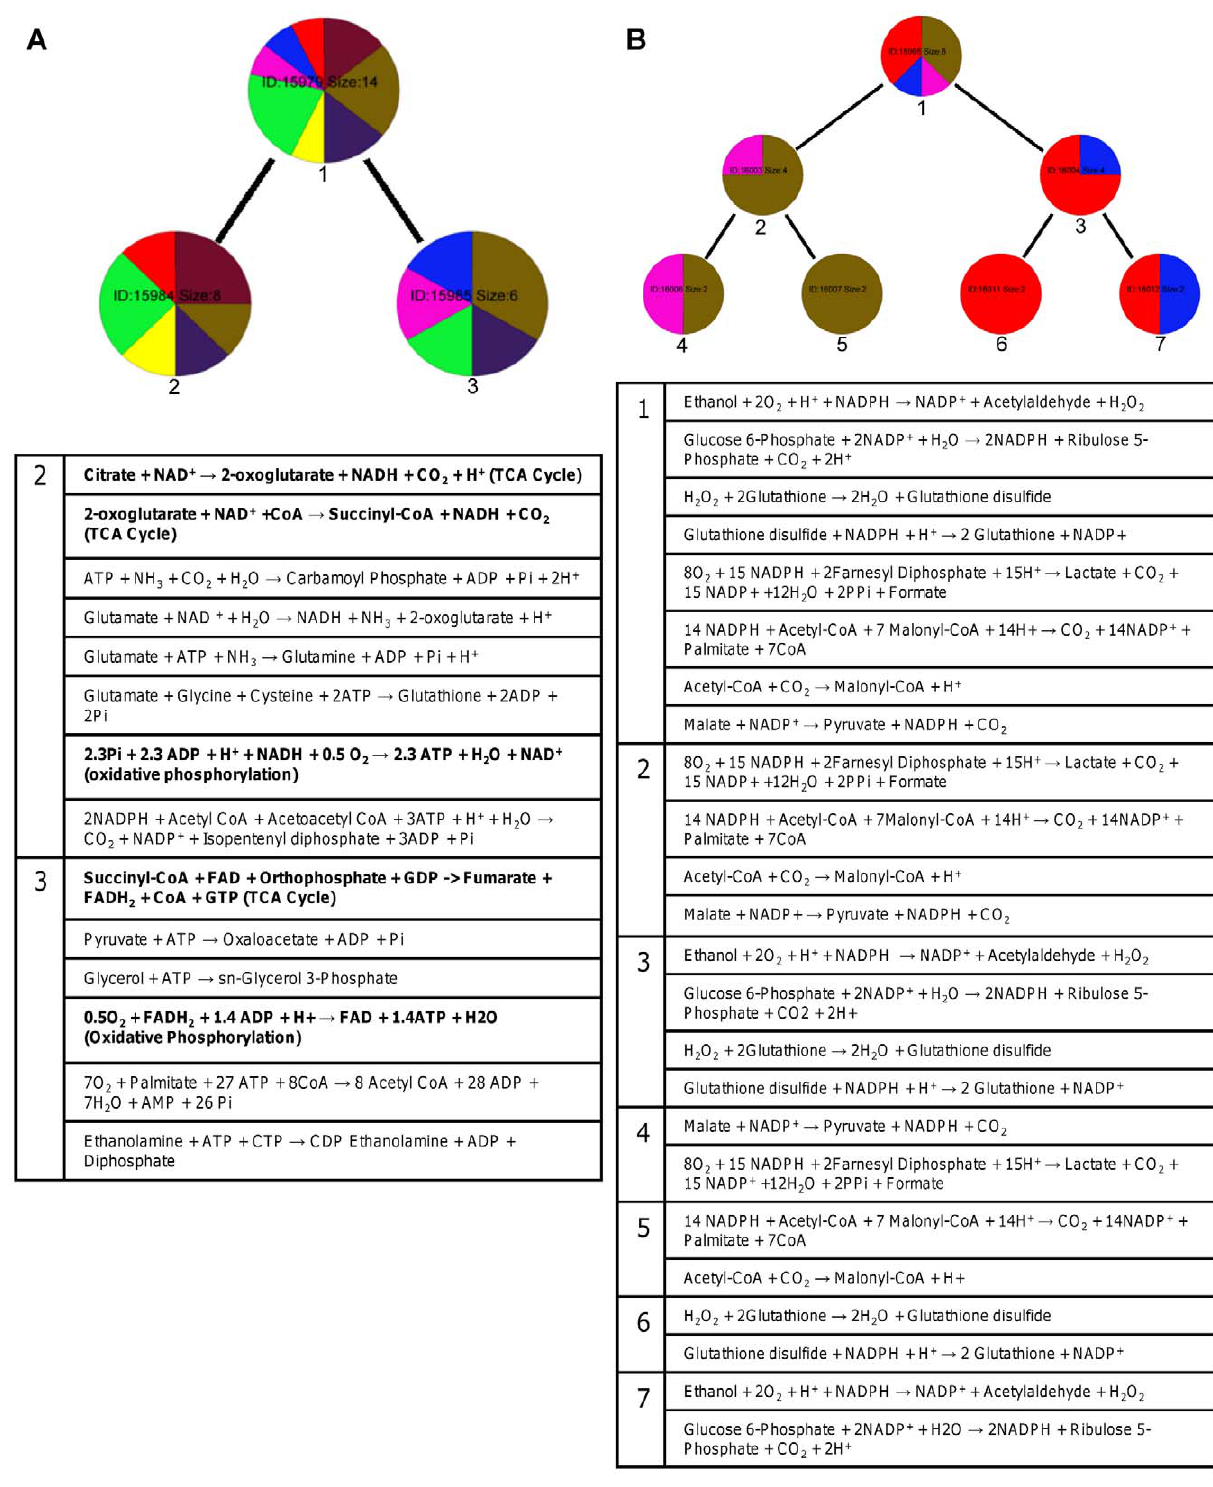
Figure 9. Redox modules. Detailed composition of modules boxed in Figure 5b. (A) Coupled reactions of the TCA cycle and oxidative phosphorylation (highlighted in bold type) metabolizing NADH and FADH 2 . (B) Coupled reactions metabolizing NADPH.